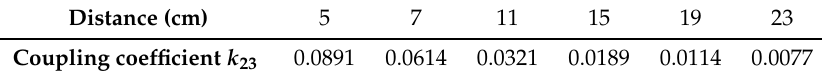
Table 3. Coupling coefficient k 23 of the coils as a function of the